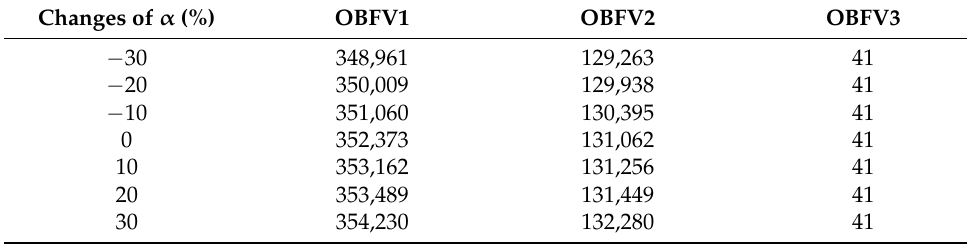
Table 8. OBFVs in changing effect of parameter 𝛼